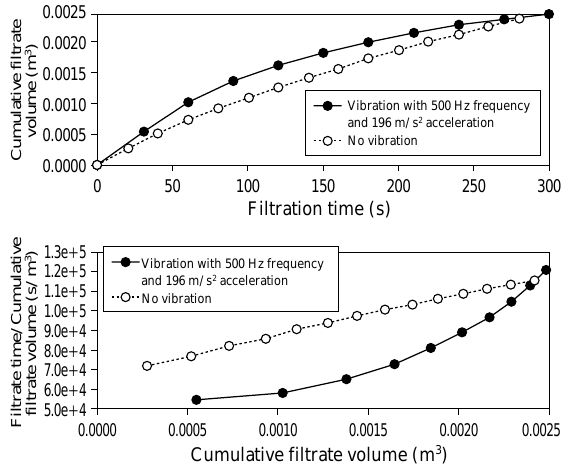
Filtrate permeation rate under conditions of different vi- bration acceleration during cake filtration experiments.